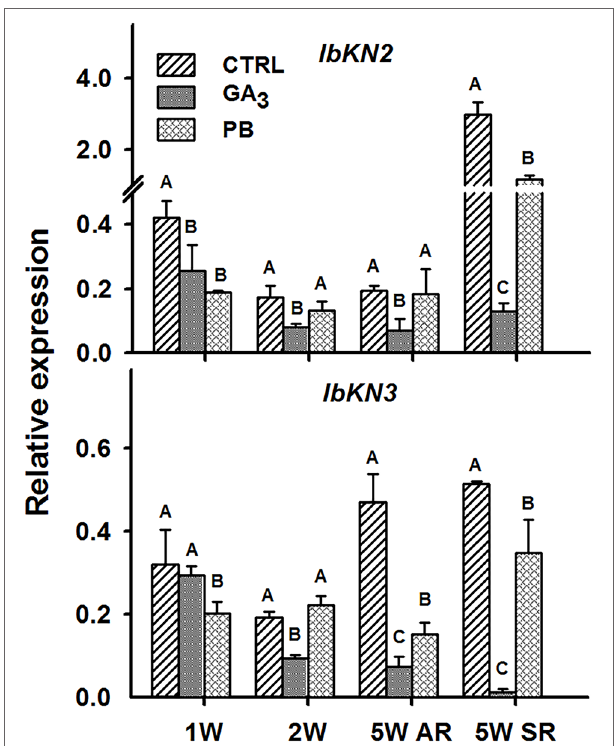
FiGURe 11 | The effect of GA 3 application on expression profiles of sweetpotato “ Georgia Jet ” class I knotted 1-like orthologs/genes in adventitious roots (AR) and storage-roots (SR). Expression/transcript levels were measured at 1W, 2W, and 5W after planting for AR and at 5W for SR, using qRT-PCR analyses, and values were normalized relative to the expression levels of phospholipase D1a. qRT-PCR data are mean (± SE) of three independent biological replicates (each representing roots pooled from four plants). Significance analysis was performed by using student’s t-test ( P ≤ 0.05 ), where unlike letters represent significant differences between treatments within a group. Control (treated with water); GA 3 , application of 50 ppm gibberellic acid 3 for two weeks; PB, application of 5 ppm paclobutrazol for two